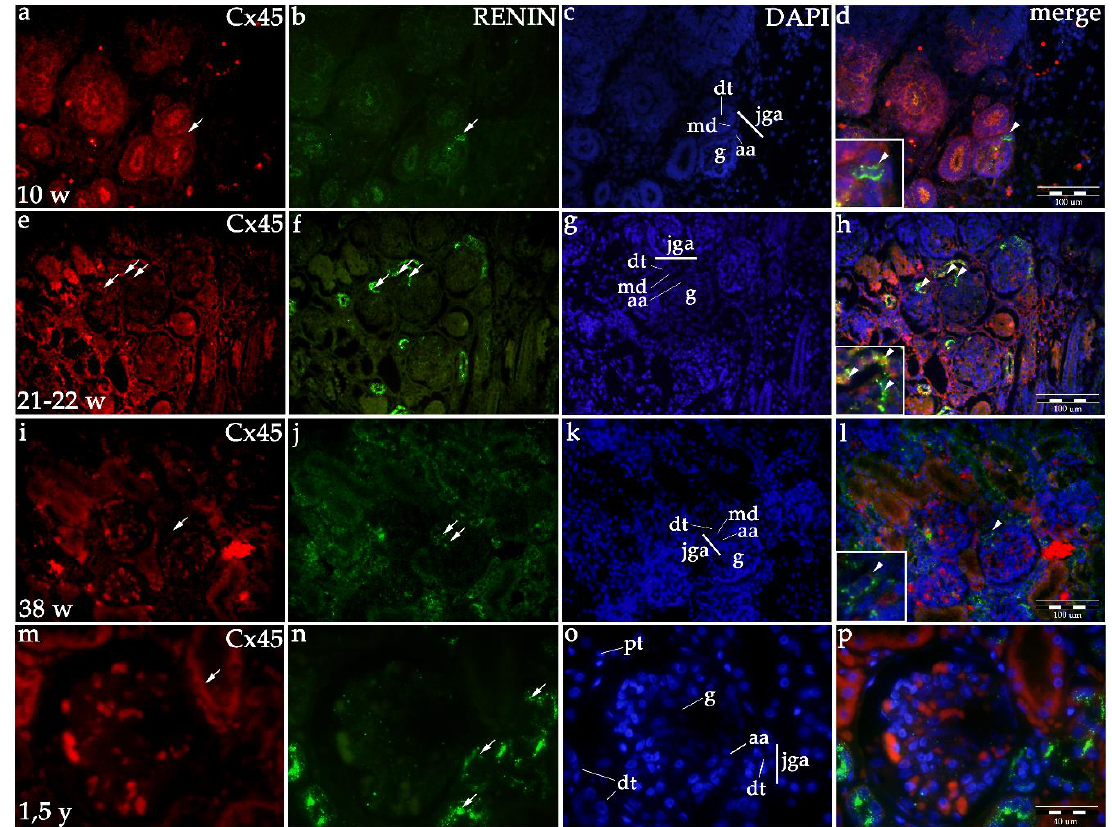
Figure 4. Co-expression of Cx45 and renin in the JGA region of developing and healthy postnatal human kidneys: kidneys in the 8th developmental week ( a – d ); kidneys in the 21–22th developmental week ( e – h ); kidneys in the 38th developmental week ( i – l ), healthy postnatal human kidneys ( m – p ). Glomeruli (g), afferent arteriole (aa), macula densa (md), juxtaglomerular apparatus (jga), proximal tubule (pt), distal tubule (dt). Cxs or renin expression (arrows), DAPI nuclear stain ( c , g , k , o ). Merged microphotographs of different Cxs with renin (merge) show their co-expression (arrowheads) in the jga ( d , h , l , p ). Double immunofluorescence staining of DAPI nuclear stain with Cx45/renin, magnification ×40, scale bar 100 μm ( d , h , l ), ×100, scale bar 40 μm ( p ).